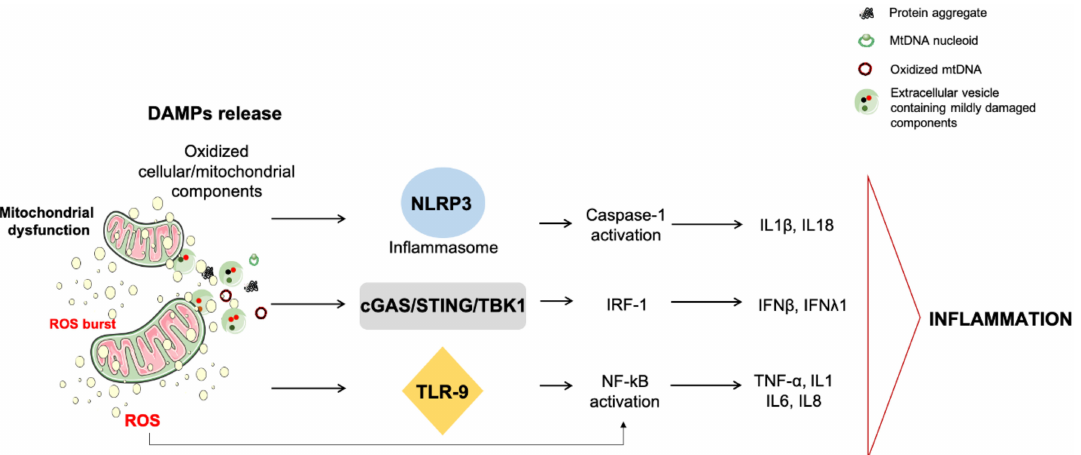
Figure 2. Signaling pathways whereby damaged-associated molecular patterns can trigger inflammation. Failing mitochondrial quality control processes may lead to intracellular accrual of damaged components and their release as damaged-associated molecular patterns (DAMPs). Acting as a DAMP, oxidized mitochondrial DNA (mtDNA) either in the form of mitochondrial transcription factor A-bound nucleoids (green circles) or free mtDNA (red circles) can trigger inflammation via interacting with (1) toll-like receptors (TLRs), (2) nucleotide-binding oligomerization domain (NOD)-like receptor family pyrin domain containing 3 (NLRP3) inflammasome, and (3) cytosolic cyclic GMP / AMP synthase (cGAS)–stimulator of interferon genes (STING) DNA-sensing system. Abbreviations : IFN, interferon; IL, interleukin; IRF-1, interferon regulatory factor 1; mtDNA, mitochondrial DNA; NF- κ B, nuclear factor κ B; ROS, reactive oxygen species; TBK1, TRAF family member-associated NF- κ B activator (TANK)-binding kinase 1; TNF- α , tumor necrosis factor